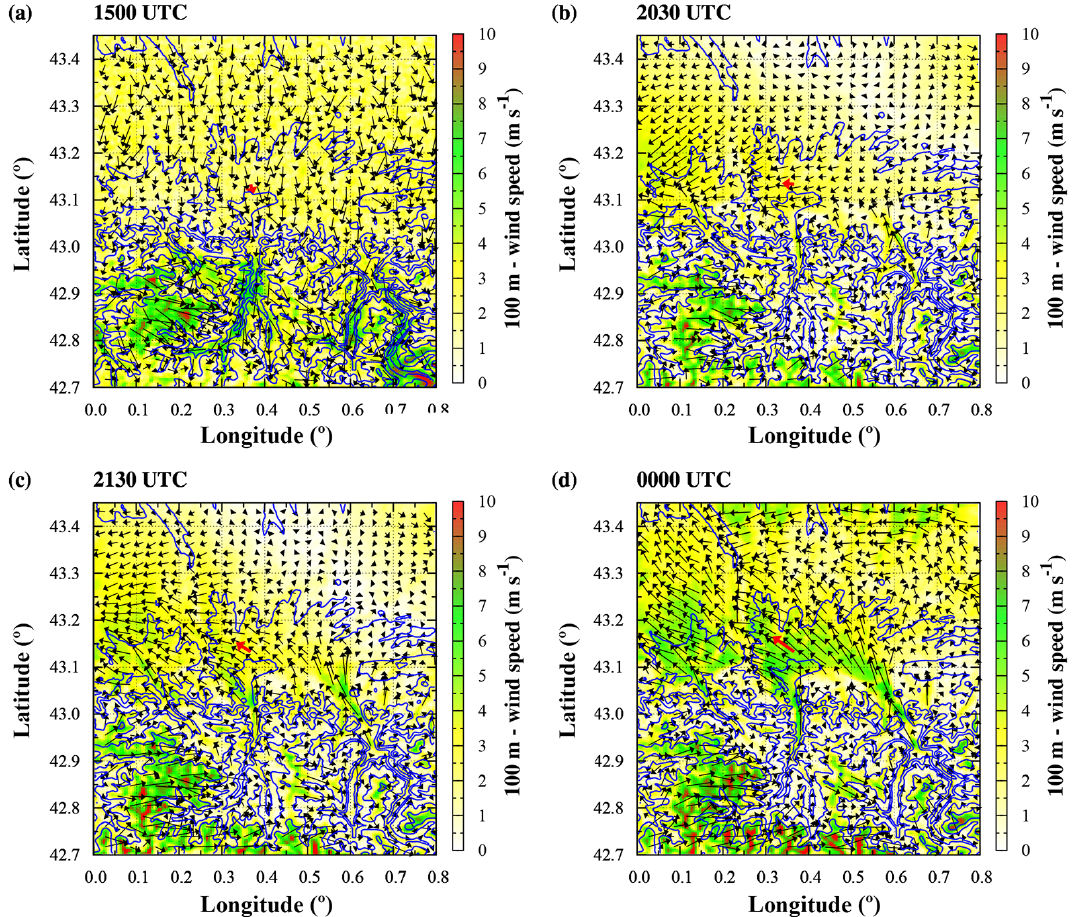
Figure 2. Modelled 100ma.g.l. wind vectors together with wind speed (in colours) and the topography lines (in blue) at different instants (a) 15:00, (b) 20:30, (c) 21:30, (d) 00:00UTC. The 60m wind vector observed by the tower is indicated with a red